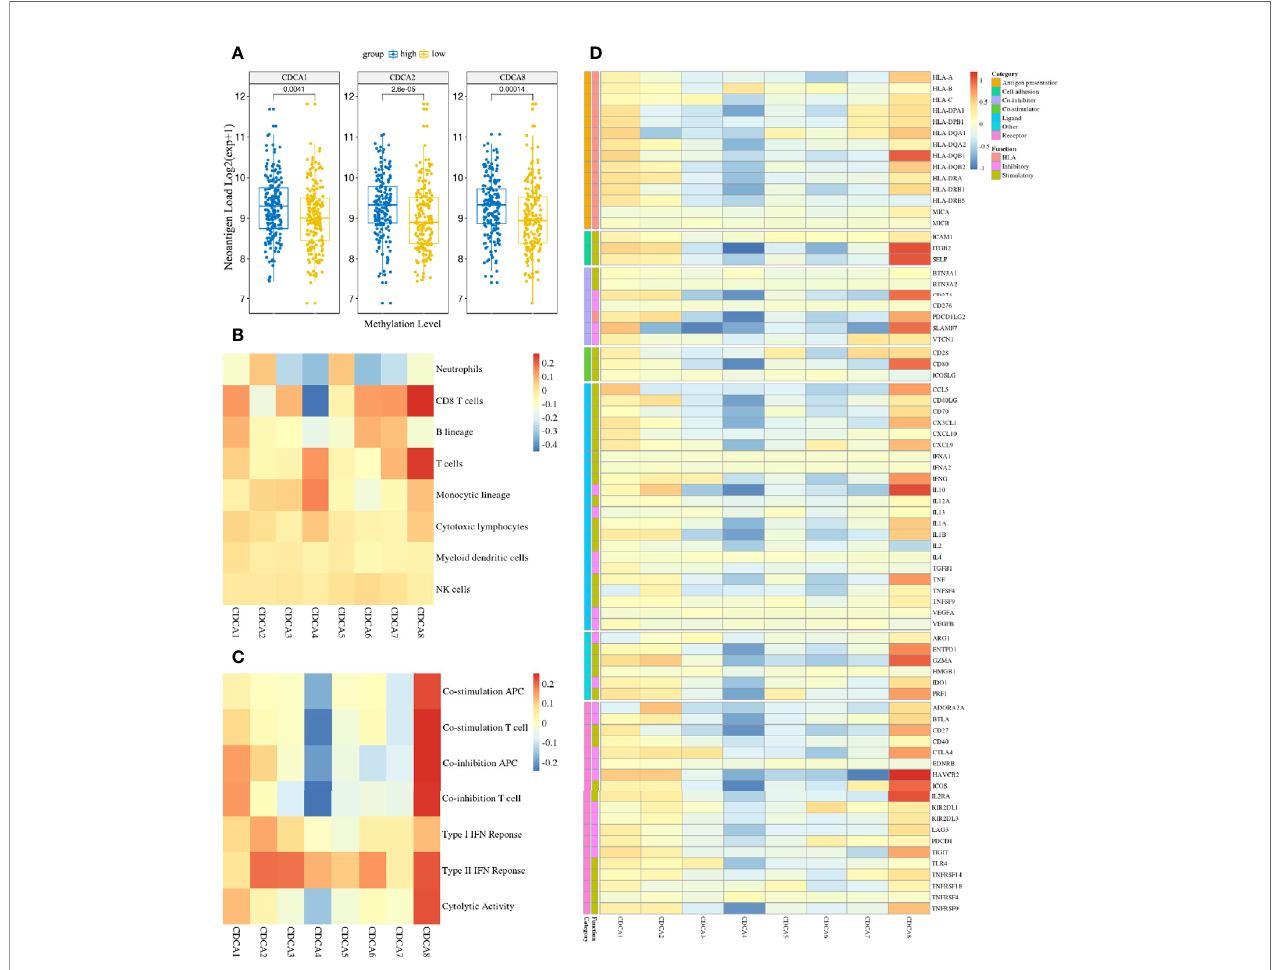
FIGURE 9 | The high-methylation CDCAs have associations with enhancing tumor immunogenicity. (A) The difference of neoantigen load between methylation groups of CDCAs in the LIHC cohorts (only show the result with signi fi cant differences). (B) Heatmap visualizes the log2FC between methylation groups in the MCP- counter scores across CDCAs. (C) Heatmap visualizes the log2FC between methylation groups in the ssGSEA scores across CDCAs. (D) Heatmap visualizes the log2FC between high and low methylation groups in the immune-related mRNA expressions across CDCAs. The y-axis indicates different immune-related genes and their function and category types. Red suggests up-regulation, while blue suggests down-regulation.